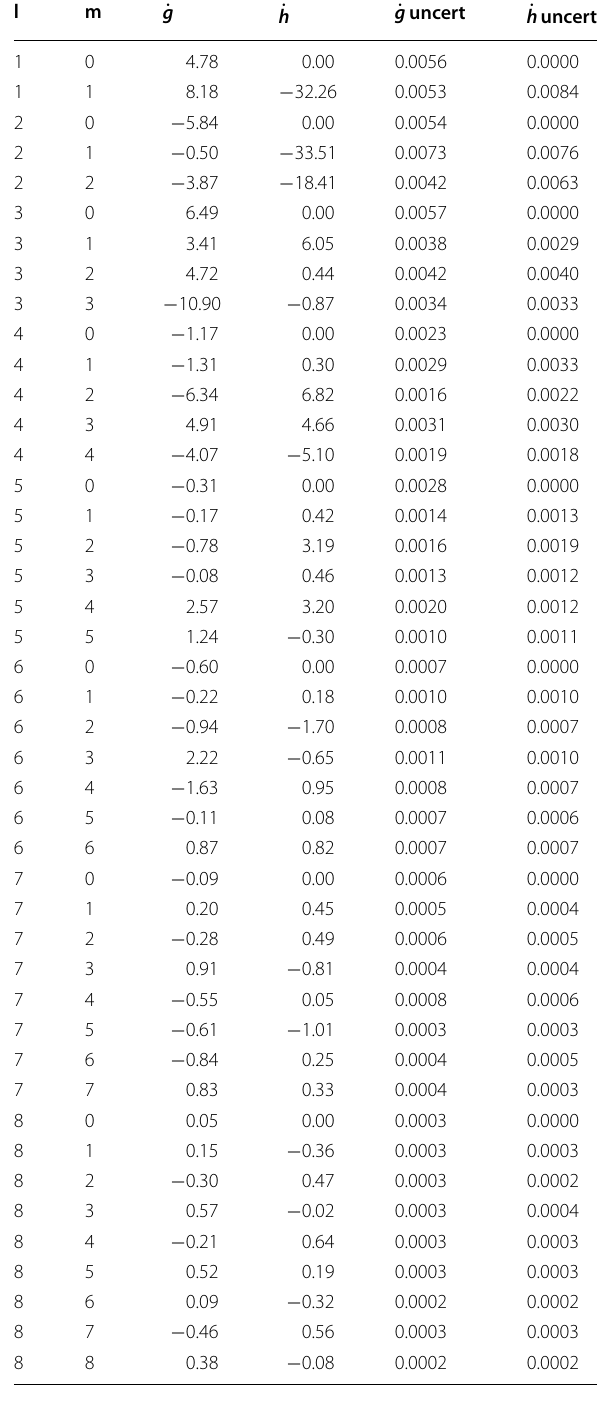
Table 4 Table of the mean SV Gauss coefficients for g m (with the unit nT/year). The axial dipole SV ˙ g 0 1 is given